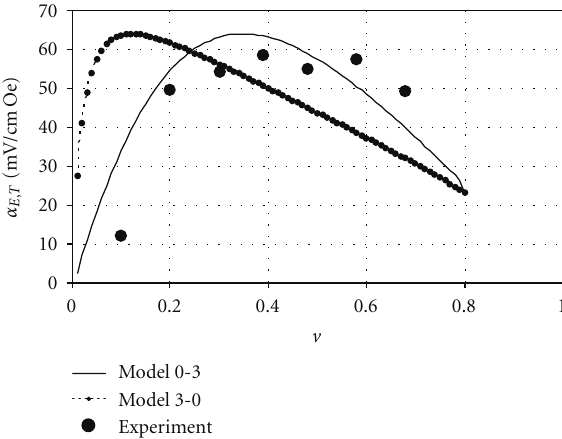
Figure 10: Concentration dependence of α E ,33 = E 3 / m H 3 for composite with material parameters from [19].